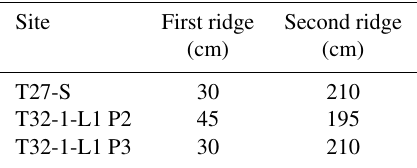
Table 4. Positions of the polygon ridges at the trench sites for which subsurface salinity profiles were collected, relative to the start of the sampling transect.